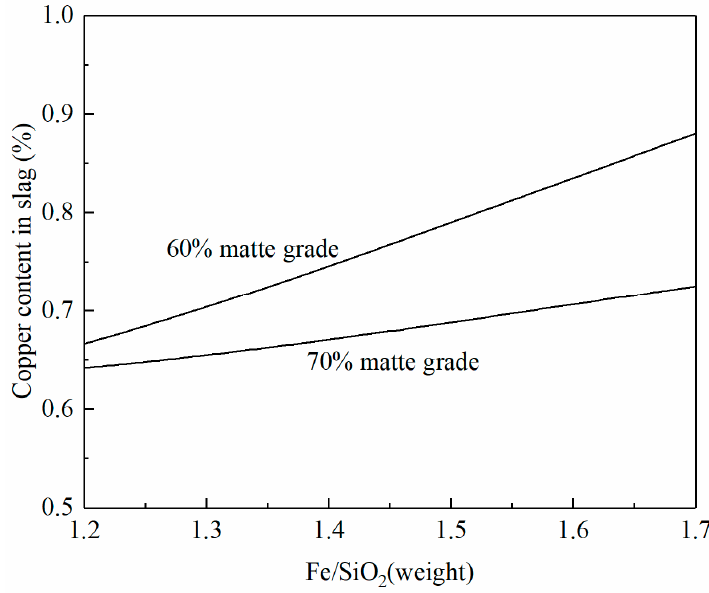
Figure 6. Effect of the Fe/SiO 2 ratio on copper content in smelting slag at 1250 °C and a fixed SO 2 partial pressure of 0.3 atm, calculated by FactSage 8.2.